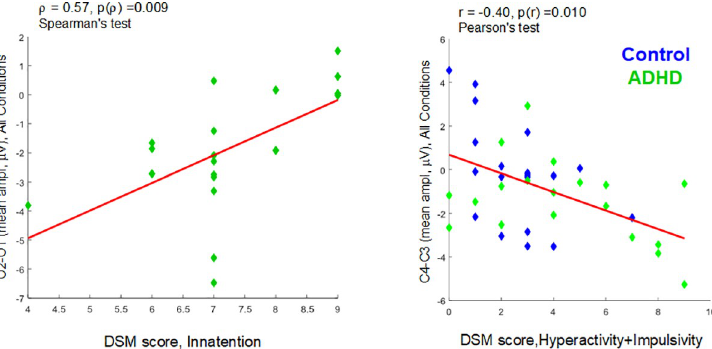
Fig 8. Scatter plots and linear regression models of correlation between asymmetries and DSM scores. Left: mean amplitudes of O2-O1 asymmetry of all conditions (AllCd) (40–200ms after target onset) versus DSM-Inattention scores in the ADHD group. Right: mean amplitudes of C4-C3 asymmetry of AllCd (45–290ms after target onset) versus DSM hyperactivity+Impulsivity scores in all subjects (blue, Control group; green, ADHD group).